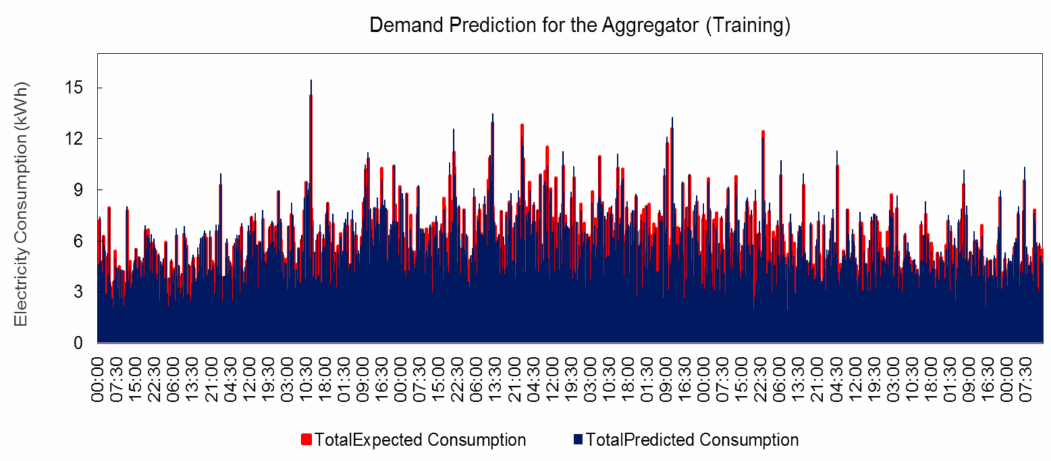
Figure 11. Comparison between the results of the aggregated actual and the aggregated predicted electricity demand for the training